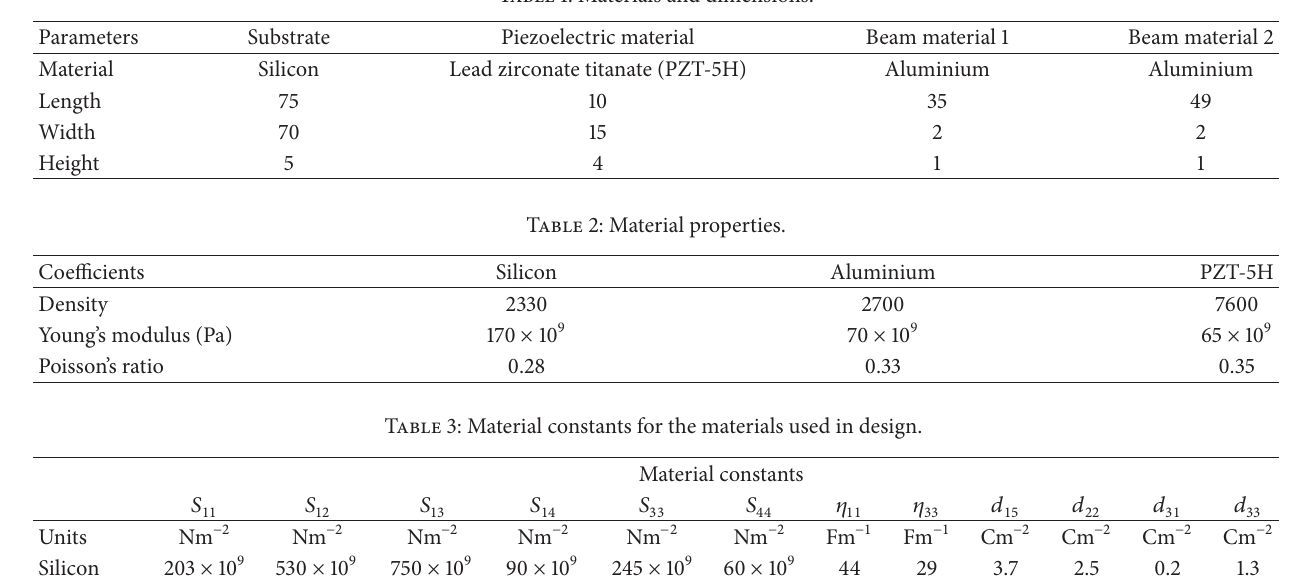
Table 1: Materials and dimensions.